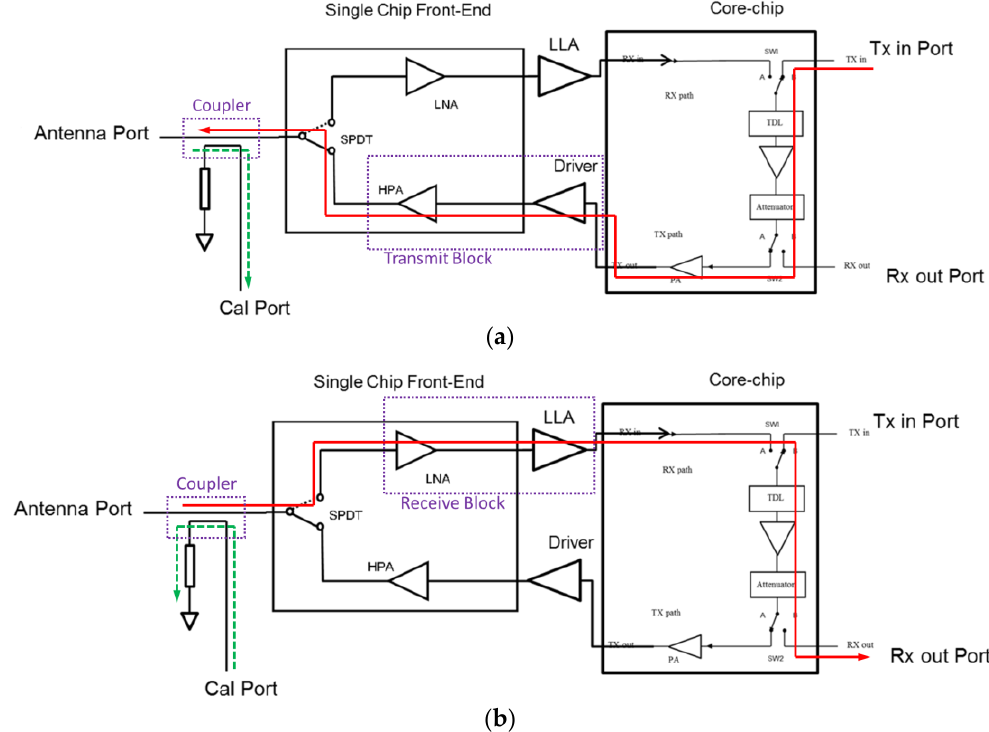
Figure 1. Identification of the paths of the electrical signals for the ( a ) TX mode of operation and ( b ) RX mode of operation. The corresponding calibration modes of operation involve also the directional coupler and the calibration port (Cal Port).